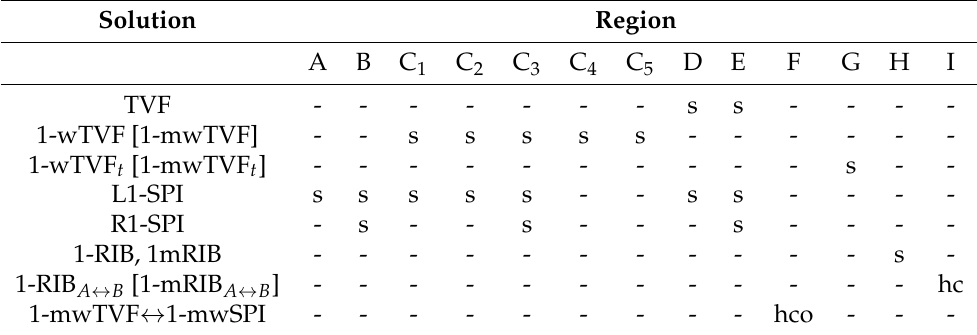
Figure 4. ( α , Re ) parameter space illustrating various solutions as indicated in Table 2. The small vertical arrows below the abscissa (a–d) highlight the parameter range of which the bifurcation diagrams are presented in Figure 3, while the dotted horizontal line at α = 0 corresponds to Figure 2. To guide the eyes some boundaries are color coded; e.g. within the red line stable R1-SPI exist, while between the orange lines stable L1-SPI exist. See text for further explanation. Table 2. Various regions, labeled A-I, as presented in the ( Re , α ) parameter space diagram in Figure 4 including their properties: stable (s), unstable or non-existent (-), heteroclinic cycle (hc), heteroclinic connection (hco). Note that the corresponding modulated flow states [ · ] indicated by “m” are present when Re (cid:54) = 0 instead of their non-modulated mother